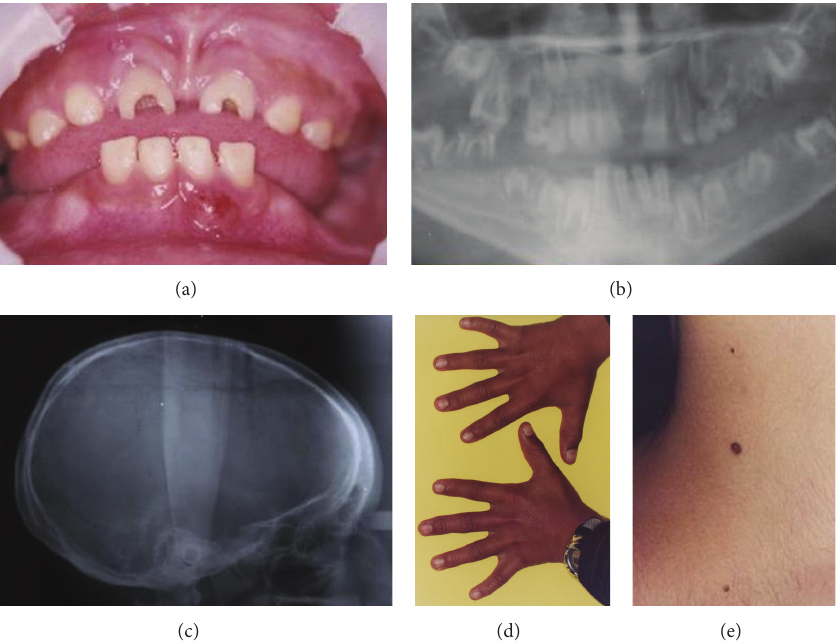
Figure 1: (a) Case 1. Oral condition of GOD at time of presentation. (b) Panoramic view showing ghost-shaped teeth, enlarged pulp chambers and root canals, and short roots and open apices. (c) Lateral cephalometric view depicting dolichocephaly. (d) Bilateral clinodactyly of the little fingers. (e) Multiple nevi on the